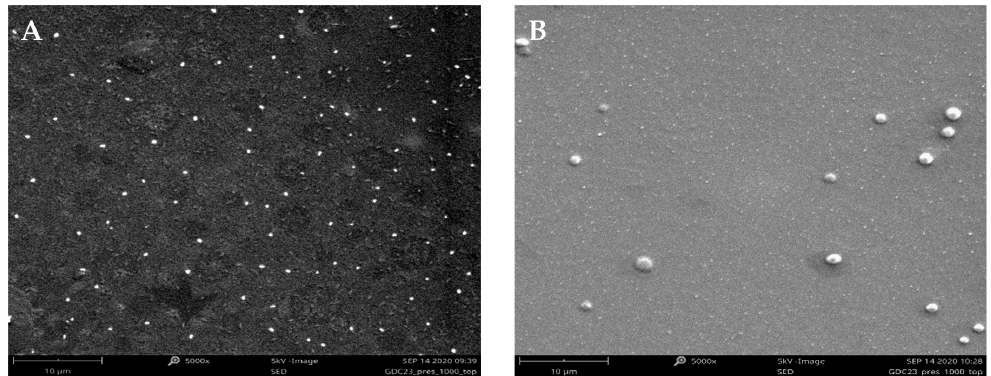
Figure 2. Representative SEM images of ( A ) PNP E and ( B ) NLP E . SEM: scanning electron microscopy, PNP E : empty polymeric nanoparticles, NLP E : empty nanoliposomes.